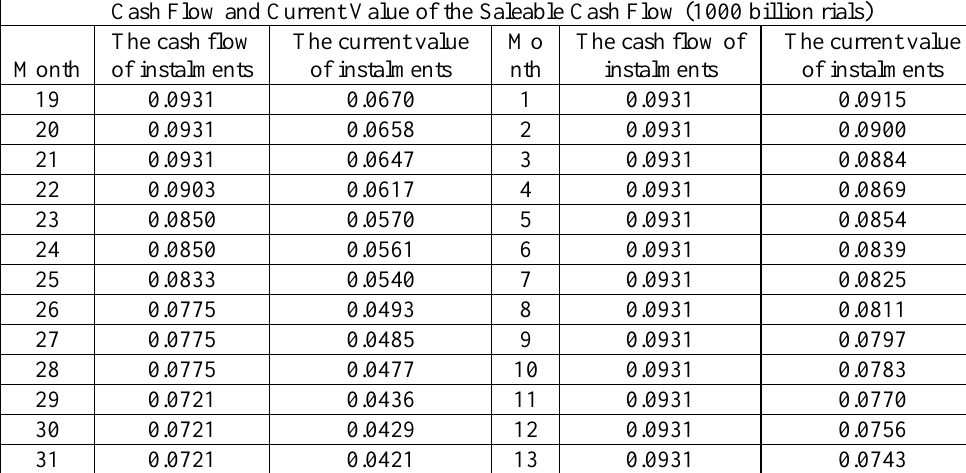
Table 4. Cash Flow and Current Value of the Saleable Cash